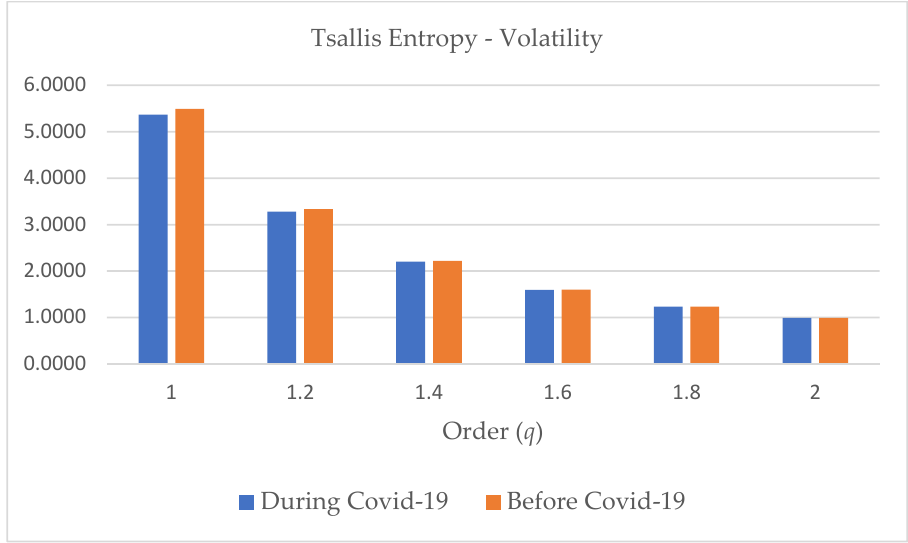
Figure 4. The plot of Tsallis entropy estimates for the two estimated volatility series of X-100.